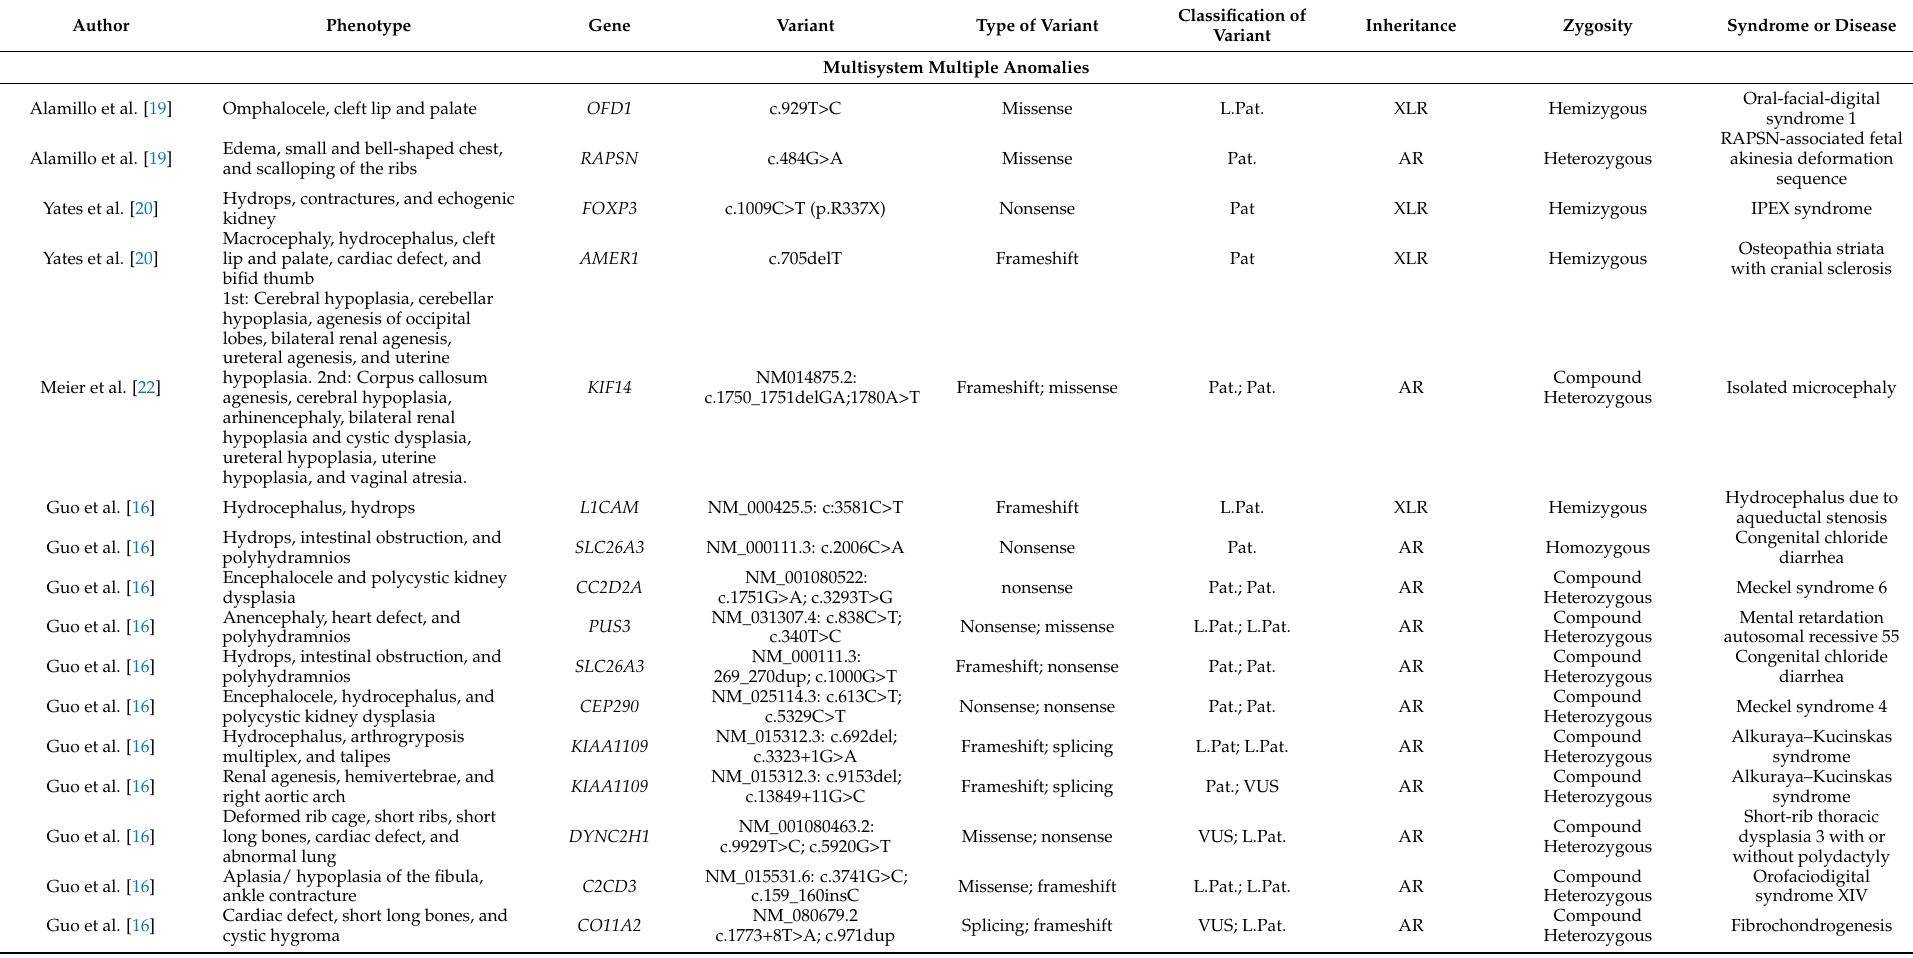
Table 2. Eighty-seven causative variants found in the 57 fetuses with recurrent structural anomalies and a positive ES result included in this systematic